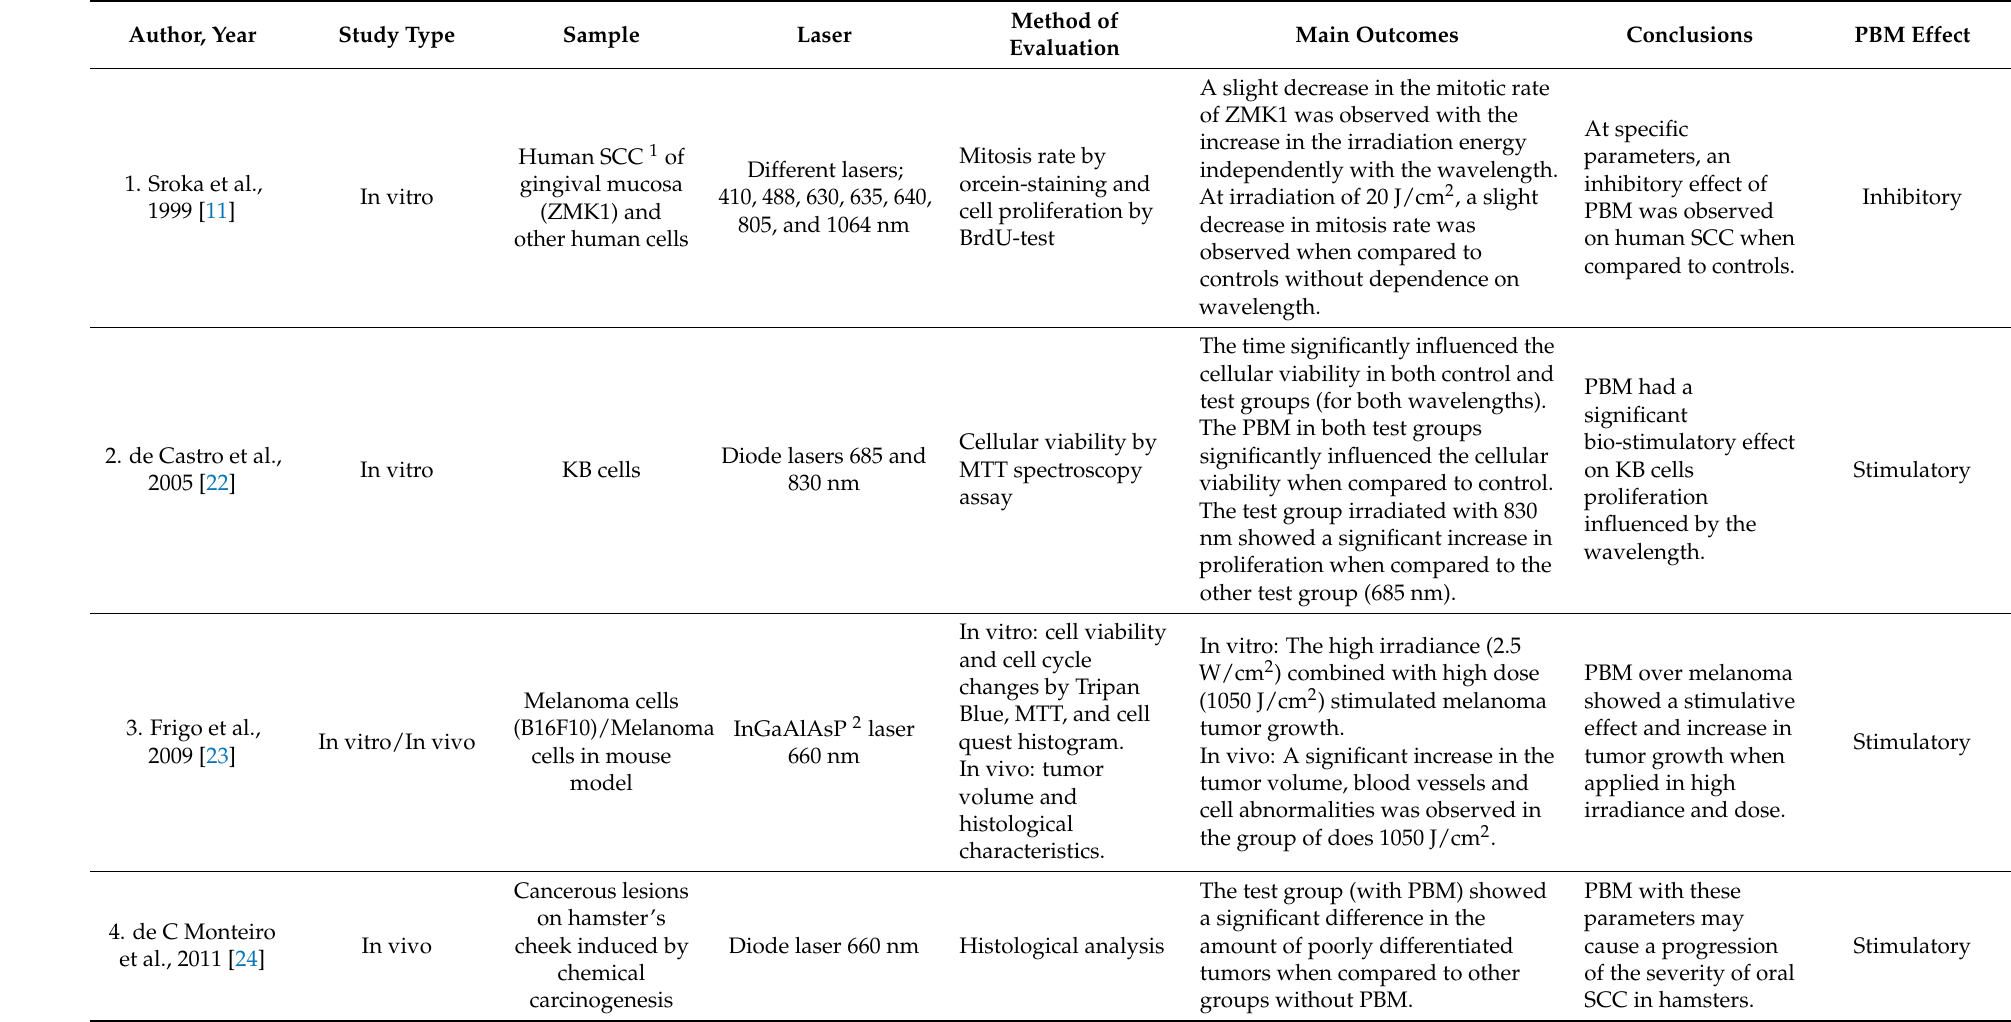
Table 2. A summarized description of all the included studies in this